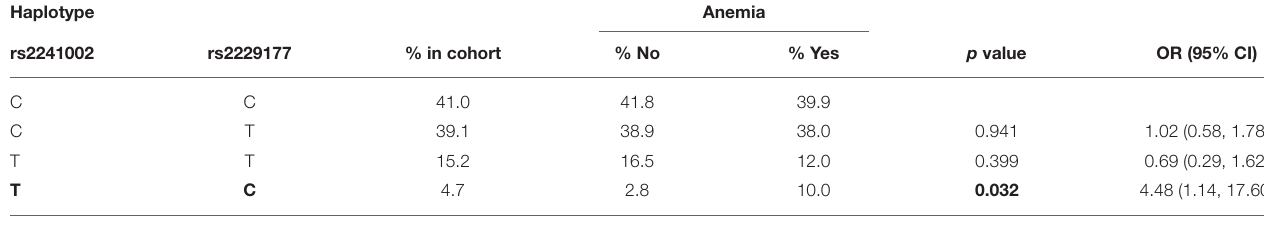
TABLE 4 | Logistic regression analysis of CD5 haplotype association to anemia and thrombocytopenia. Haplotype